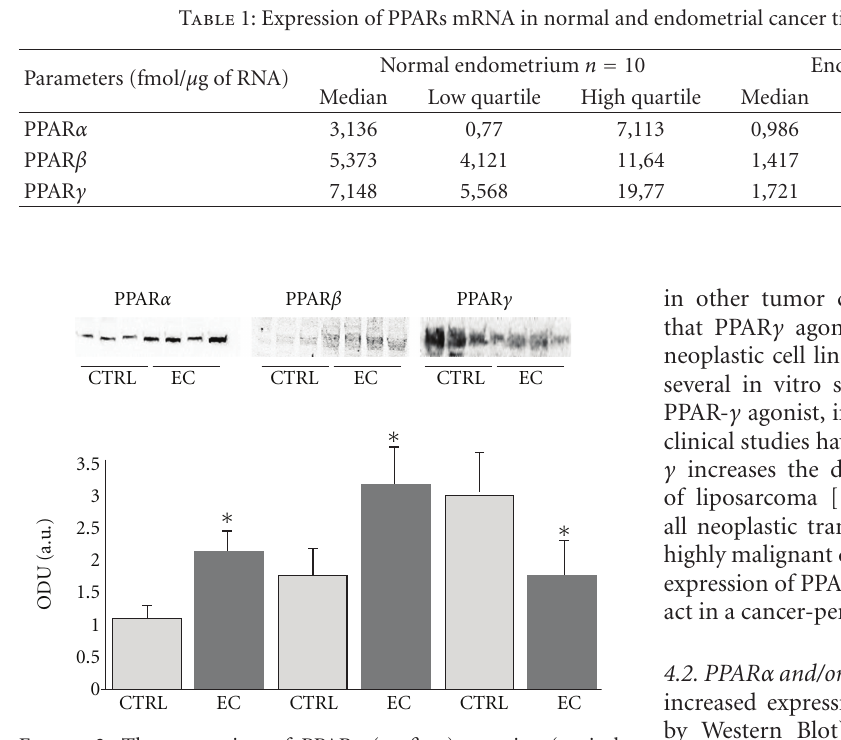
Figure 2: The expression of PPARs ( α , β , γ ) proteins (optical density units (ODU)) in normal and endometrial cancer tissues. ∗ P < 0 . 05 (CTRL); normal endometrium versus endometrial cancer